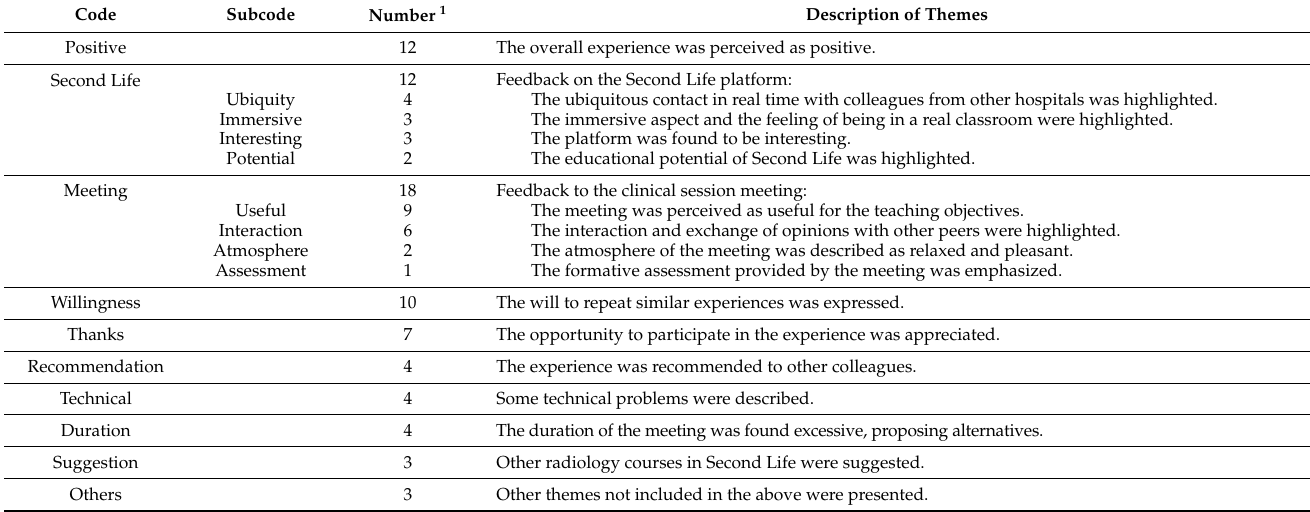
Table 2. Thematic coding of open